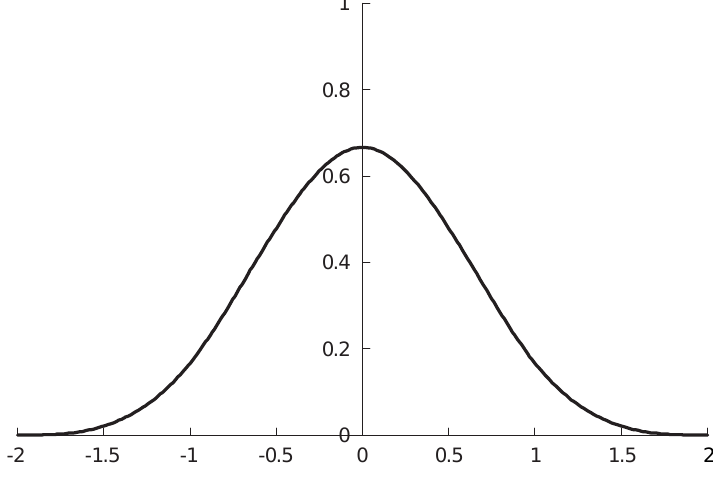
Fig. 1. Standard cubic B-spline function.